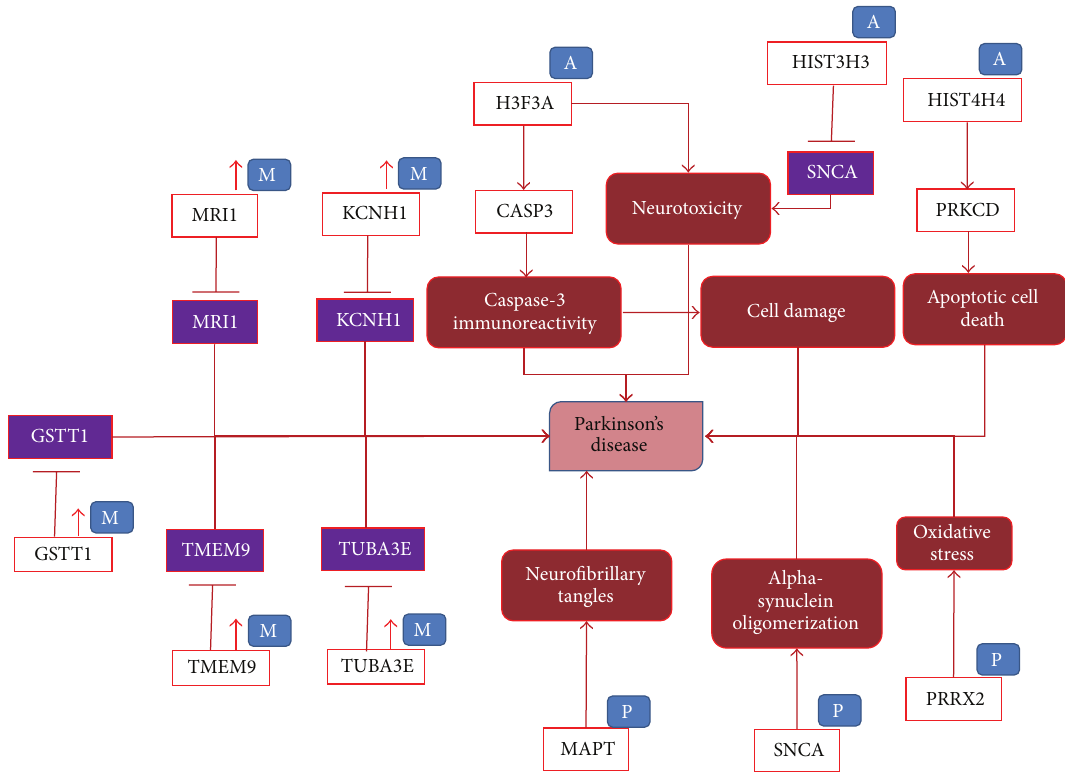
Figure 3: The role of epigenetics modification, hypermethylation, phosphorylation, and acetylation around certain genes in PD. In this figure also red lines indicate the disease state interactions. “M” associated with a gene entity denotes a methylation process and up-arrows besides represent an increase of methylation. “P” and “A” represent the phosphorylation and acetylation processes, respectively. Genes in purple boxes denote lower expression of